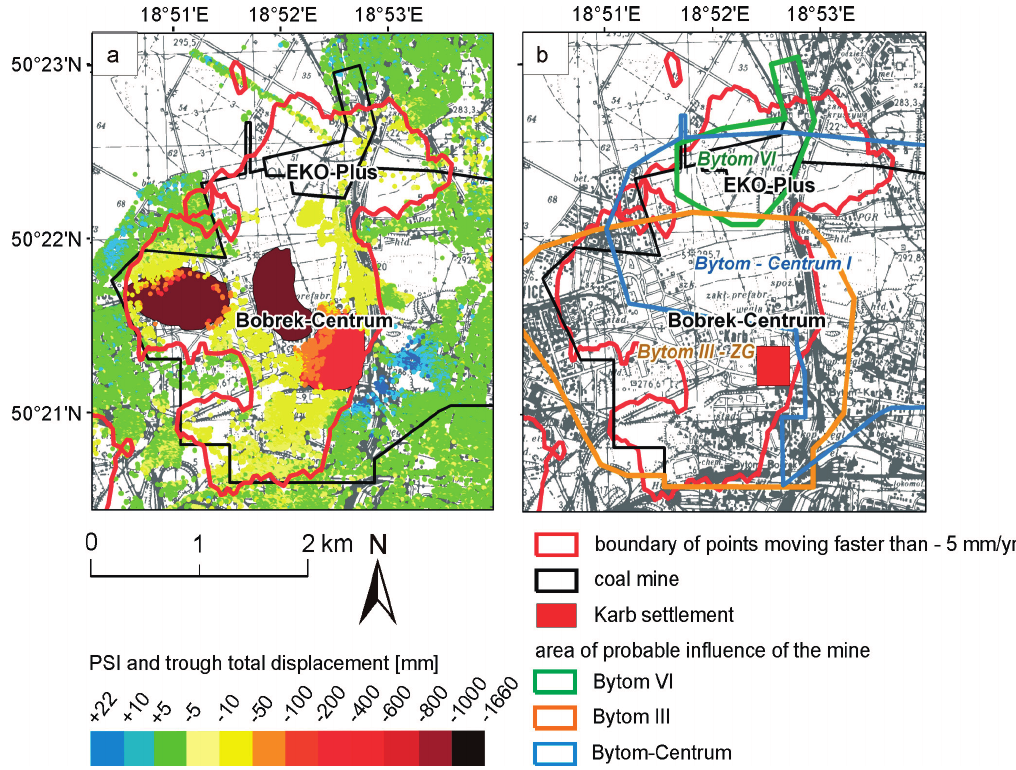
Figure 11. ( a ) Permanent Scatterers Interferometry (PSI) cumulated displacement map with the boundary of PSI points moving faster than − 5 mm/year (red line). Common color scale is used both for PSI and the troughs cumulated displacement value. Note that in the case of the troughs the value refers to the maximum detected subsidence within the whole period of observation. ( b ) Areas of probable influence of the mining activity, named: Bytom VI, Bytom III and Bytom-Centrum (green, orange and blue lines respectively) according to